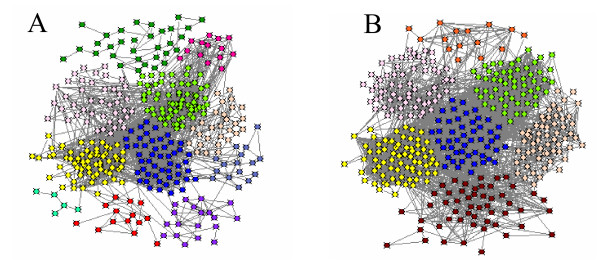
Conserved and different modules in metabolic network between chloroplasts and Synechococcus sp. WH8102 (syw). The modular structures of enzyme-centric networks for chloroplasts and syw are shown in (A) and (B) respectively. Each module is represented by a specific color. The five pairs of modules with same color are conserved modules between chloroplast and syw, among which the yellow, green and blue modules correspond to amino-acid metabolism, the light-orange and pink modules belong to carbohydrate metabolism and nucleotide metabolism respectively. The picture was drawn using the Pajek program.